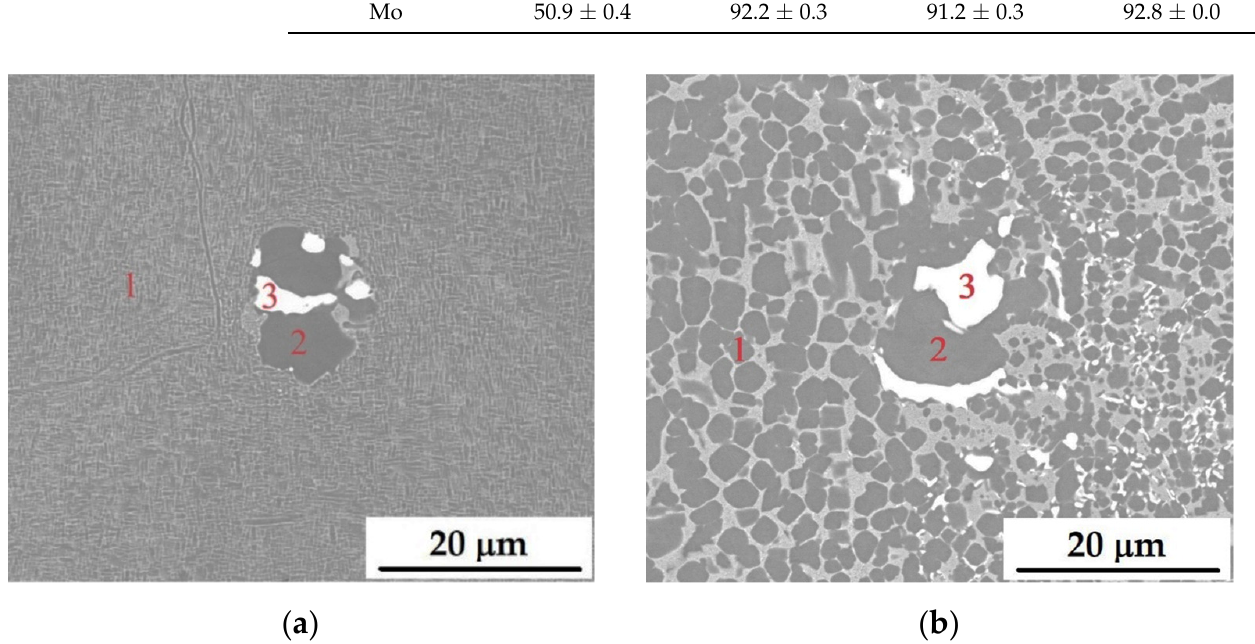
Figure 6. Microstructure of sample A: ( a ) Sample A50 after DS at rate 50 mm/h; ( b ) Sample A20 after DS at rate 20 mm/h; 1—two-phase regions γ / γ′ , 2— γ′ -Ni 3 (Al,Mo) phase, 3—Mo-rich phases.